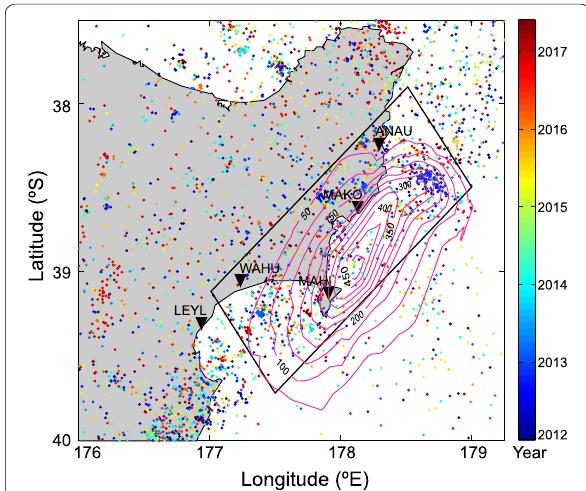
Fig. 6 Seismicity Map of North Island, New Zealand and the target study area. Epicenters of earthquakes with magnitudes M ≥ 2.5 in the North Island (New Zealand) region with depths shallower than 65 km for the period 2012/01 to 2017/5 selected from the GeoNet catalog. The contours (in mm/year) show the cumulative slip of all detected SSEs on the Hikurangi subduction interface since 2002 until 2012, b taken from Wallace et al. (2012). Only the earthquakes with epicenters in the spatial window shown are considered for analysis in this study. Also displayed in the figure are the locations of cGPS station whose data are examined in the present study to investigate the association